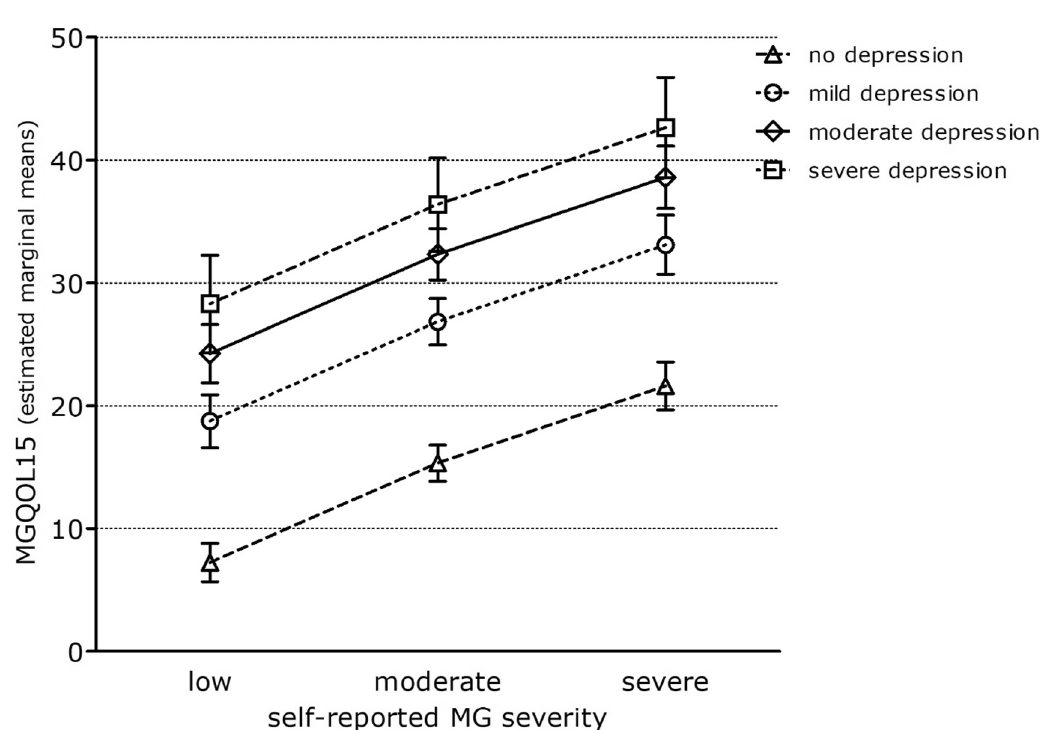
Figure 1. Adjusted MGQOL15 scale scores for different severities of depression according to HADS. Estimated marginal means with 95%CI for MGQOL15 scale scores after full adjustment for depression, gender, thymectomy, other autoimmune disease, cardiovascular disease, IVIG/Rituximab, myasthenic crisis/ exacerbation, duration, disease latency age, education, marital status. MGQOL15 = Myasthenia gravis Quality of Life Score, short version; HADS = Hospital Anxiety and Depression